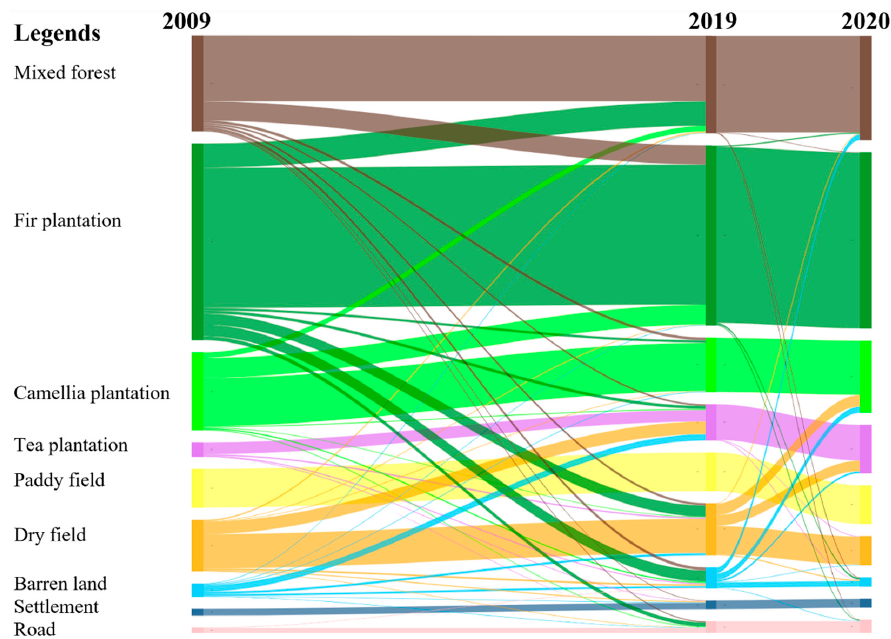
Figure 6. Land-use compositions for 2009, 2019 and 2020, and related inter-year changes indicated by flows between land-use types in each year.